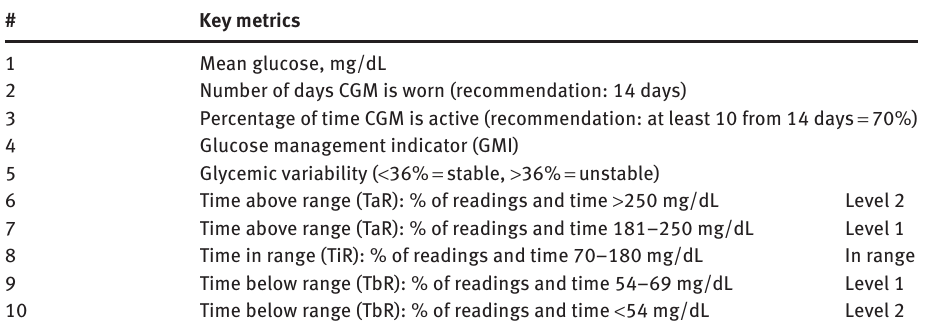
Table 2: Key metrics for CGM data analysis and reporting [36].